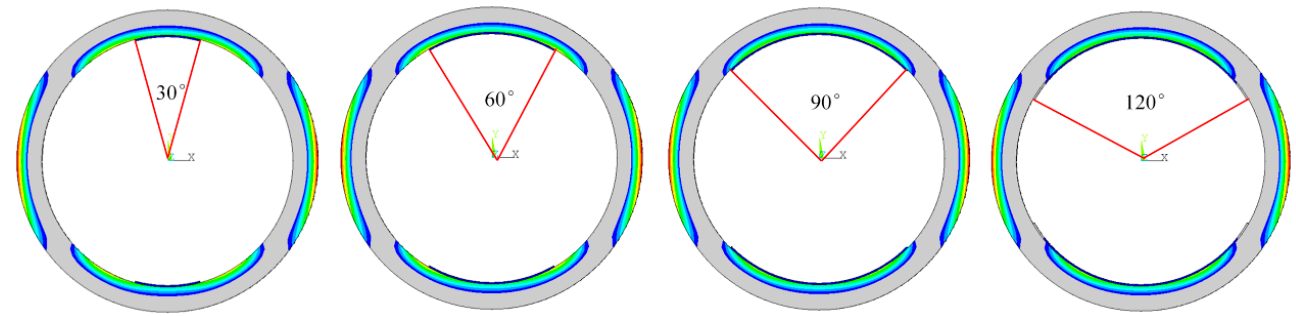
Figure 8. Concrete tensile areas and pasted angles.